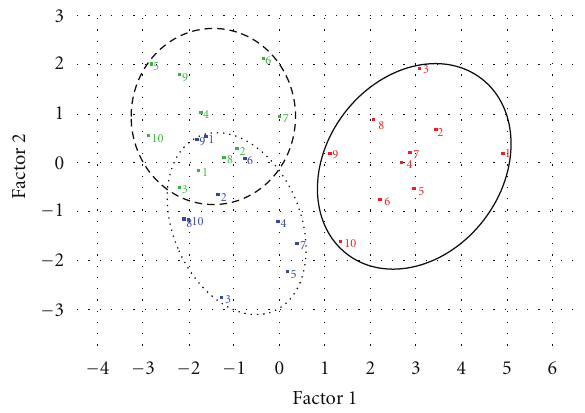
Figure 5: Canonical projection plot of E-nose sensor responses after training the E-nose to recognize VOC emissions from 10 unexposed (control) bolls (solid ellipsoid) and 10 bolls exposed to Euschistus servus (fine-dashed ellipsoid) and Nezara viridula (broad-dashed ellipsoid) following a 3 d